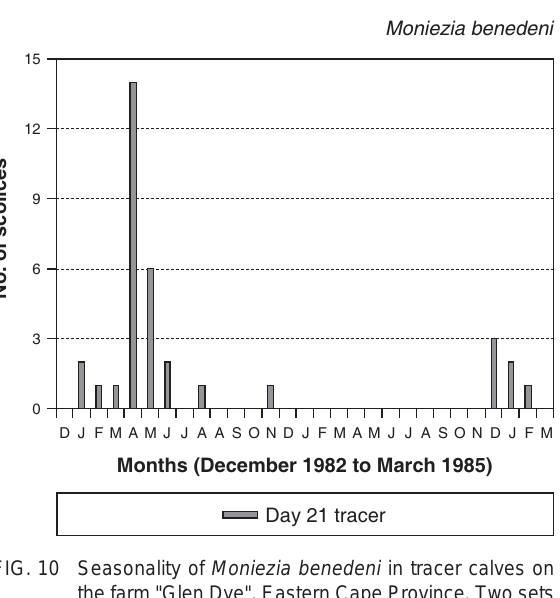
FIG. 10 Seasonality of Moniezia benedeni in tracer calves on the farm "Glen Dye", Eastern Cape Province. Two sets of calves were examined during August